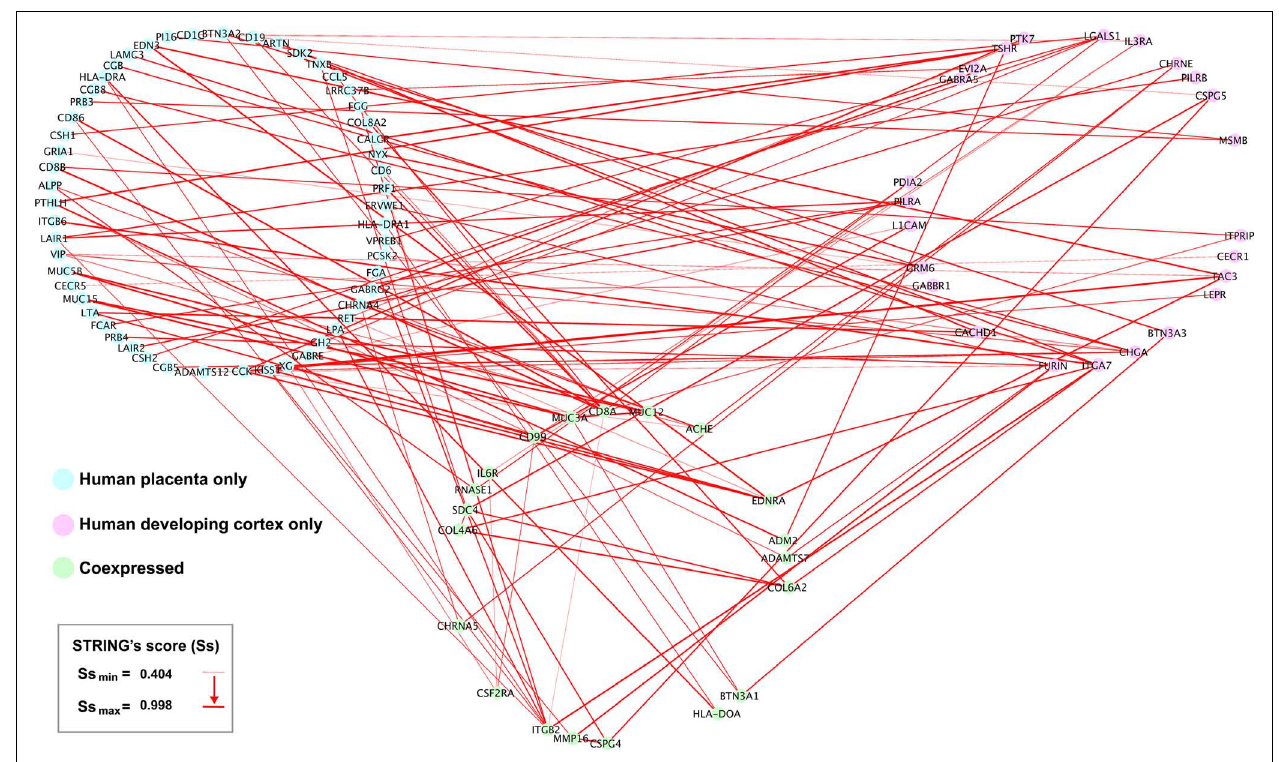
FIGURE 7 | Placental interactions with the developing human cerebral cortex. From the subset of interactions generated from the STRING analysis (Figure 6) , we manually selected those genes interacting with human developing cerebral cortex genes. Interacting human placental, human developing cerebral cortex genes, and pairwise STRING’s interaction scores